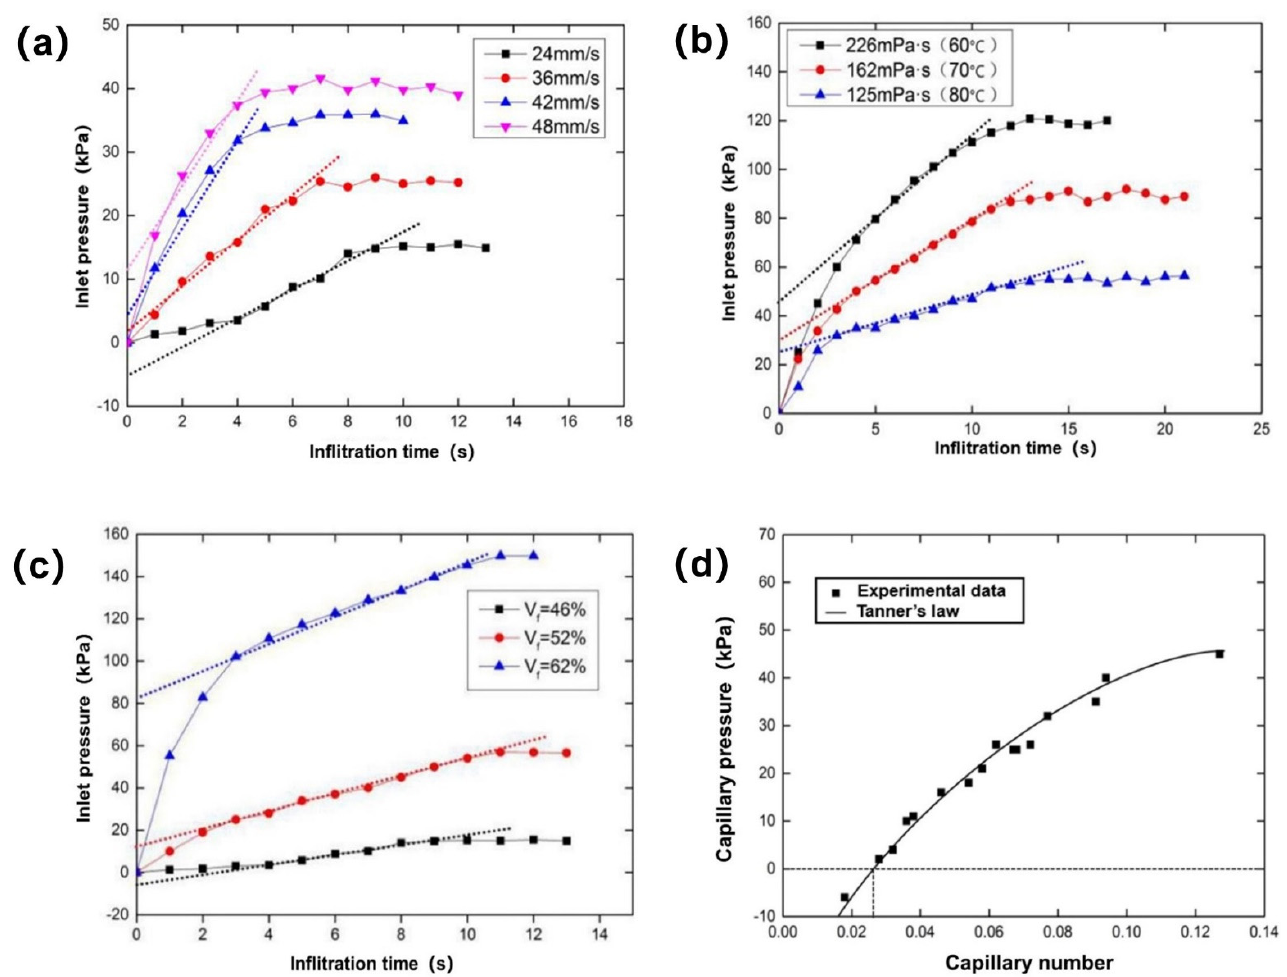
Figure 12. ( a ) Influence of injection rate on inlet pressure variation. ( b ) Influence of resin viscosity on inlet pressure change. ( c ) Influence of fiber volume fraction on inlet pressure. ( d ) Influence of capillary number on capillary pressure during infiltration.